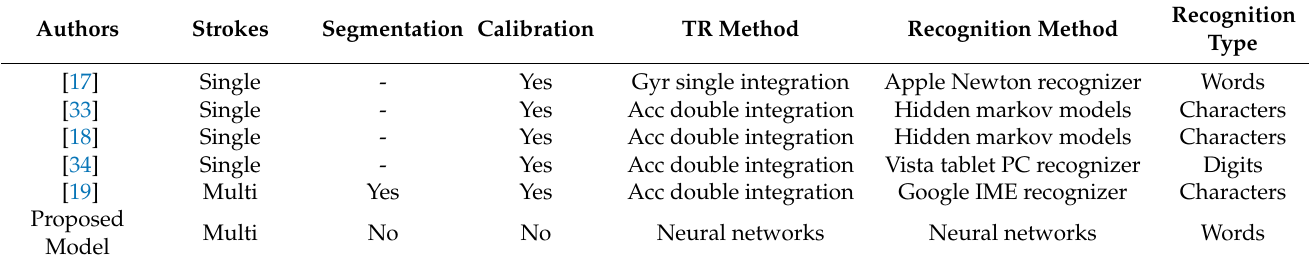
Table 1. Summary of the related work of trajectory reconstruction systems. Gyr and Acc represent gyroscope and accelerometer, repectively.